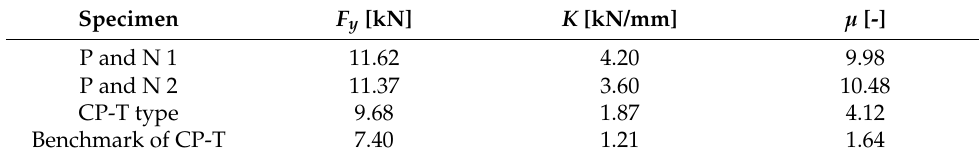
Table 4. Seismic performance parameters from the bilinear diagrams of the pullout tests.